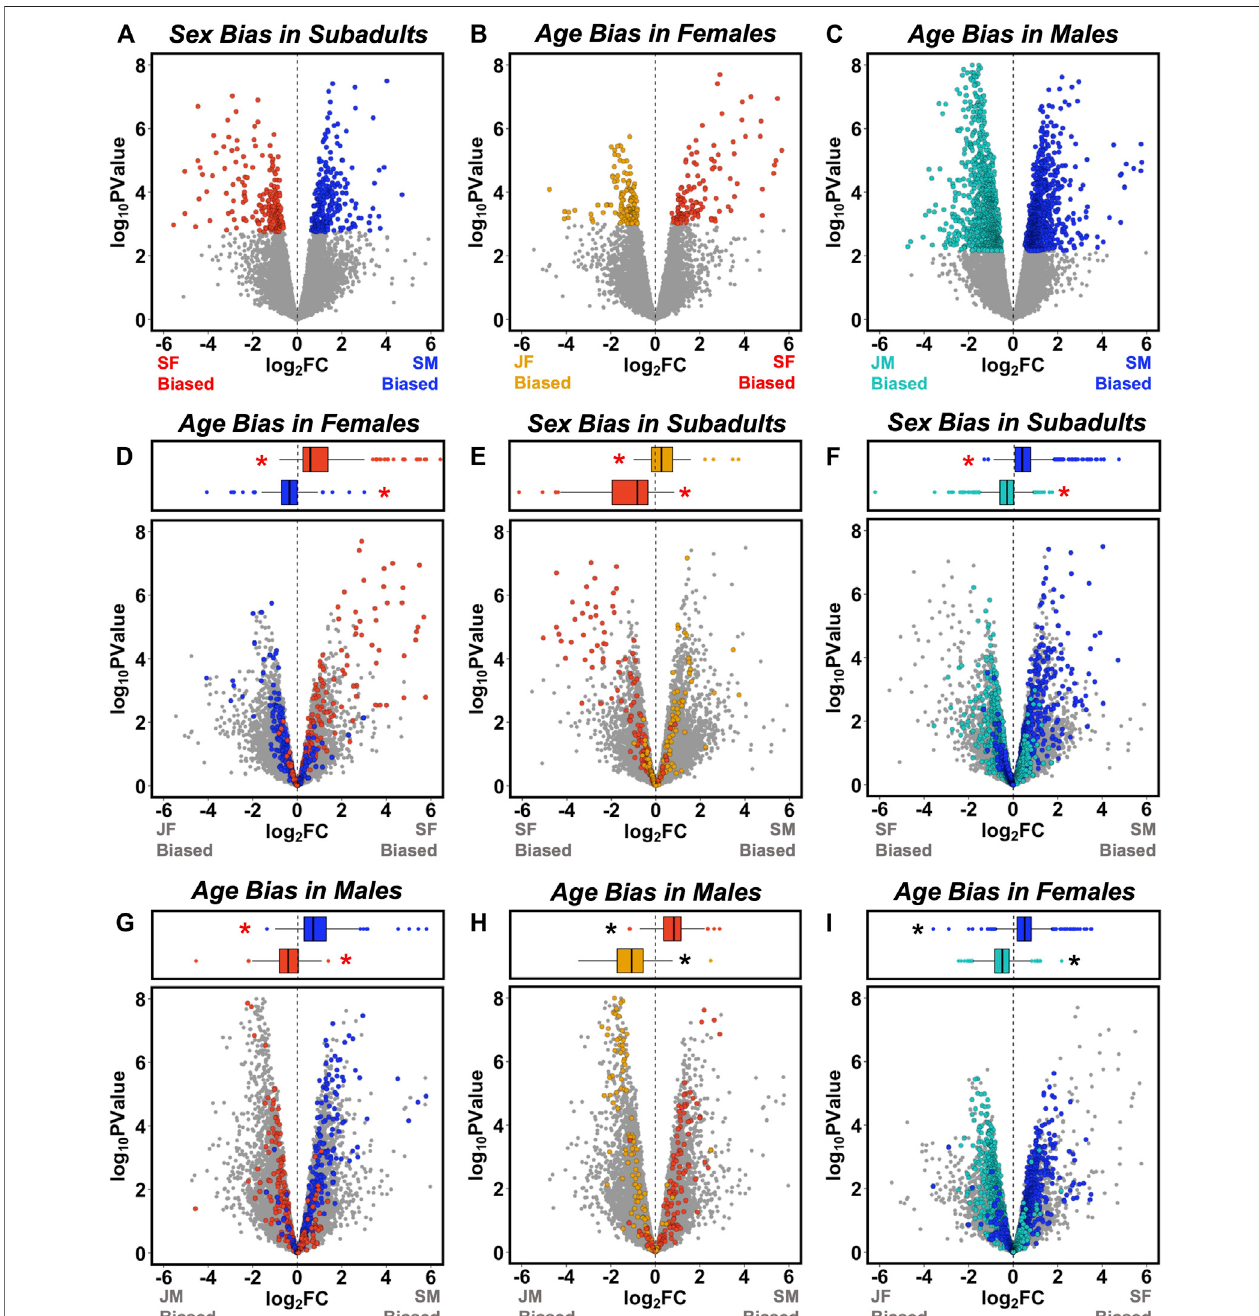
FIGURE 2 | Overlap between sex-and age-biased gene expression. Volcano plots in the top row illustrate patterns of (A) sex-biased expression in subadults, (B) age-biasedexpressioninfemales,and (C) age-biasedexpressioninmales,withdifferentiallyexpressedgenes(DEGs,FDR < 0.05)shownincolorandothergenesingray (as in Figure 1 ). In the left column, sex-biased DEGs from (A) are mapped onto plots describing age-biased expression in (D) females, and (G) males. In the middle column, female age-biased DEGs from (B) are mapped onto plots describing (E) sex-biased expression, and (H) age-biased expression in males. In the right column,maleage-biasedDEGsfrom (C) aremappedontoplotsdescribing (F) sex-biased expression, and (I) age-biased expressioninfemales.Box-and-whiskerplots aboveeachpanelreportthemedian(line),upper75%andlower25%(box),andupper95%andlower5%(whiskers)forthelog 2 foldchange(FC)valuesofeachcategory of DEG [from (A – C) ] when mapped onto the corresponding volcano plots. Asterisks indicate mean log 2 FC values signi fi cantly different from zero following Bonferroni correctionformultiple comparisons (adjusted p < 0.0042). Redasterisksindicatetests forwhichtheclassi fi cationofDEGsisnotstatisticallyindependent ofthelog 2 (FC) values on the volcano plot because the same group is included in each comparison.